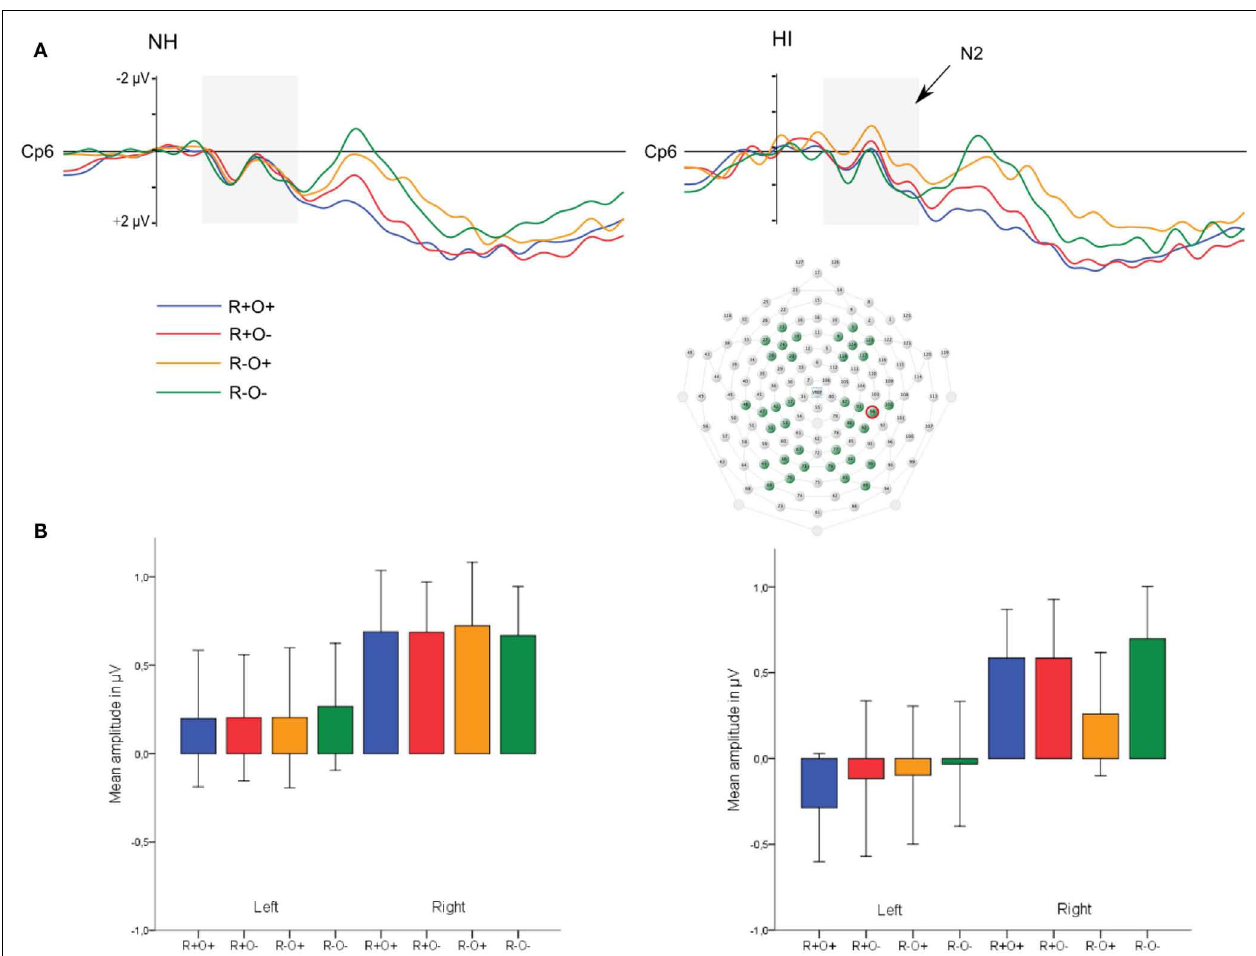
FIGURE 9 | (A) Grand average ERP waveforms at electrode Cp6 and (B) mean amplitudes in the right hemisphere elicited by R + O + , R + O − , R − O + , and R − O − target words in the 100- to 300-ms latency window, long ISI, divided by group. Error bars represent 95%